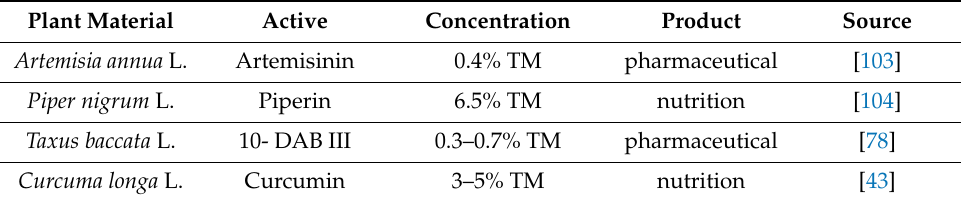
Table 2. Presence of secondary plant